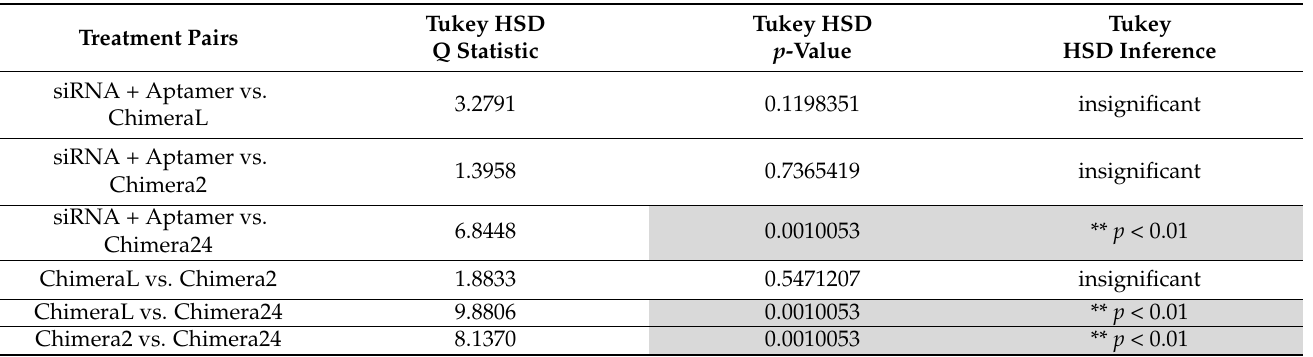
Table 4. Statistical comparisons of treatment options tested in this study to determine the most effective treatment option for RABV in a p.i. scenario. All negative results were removed from the analyses. Shaded cells indicate statistical significance. vs.—versus. ** indicates statistically significant differences between treatment types.